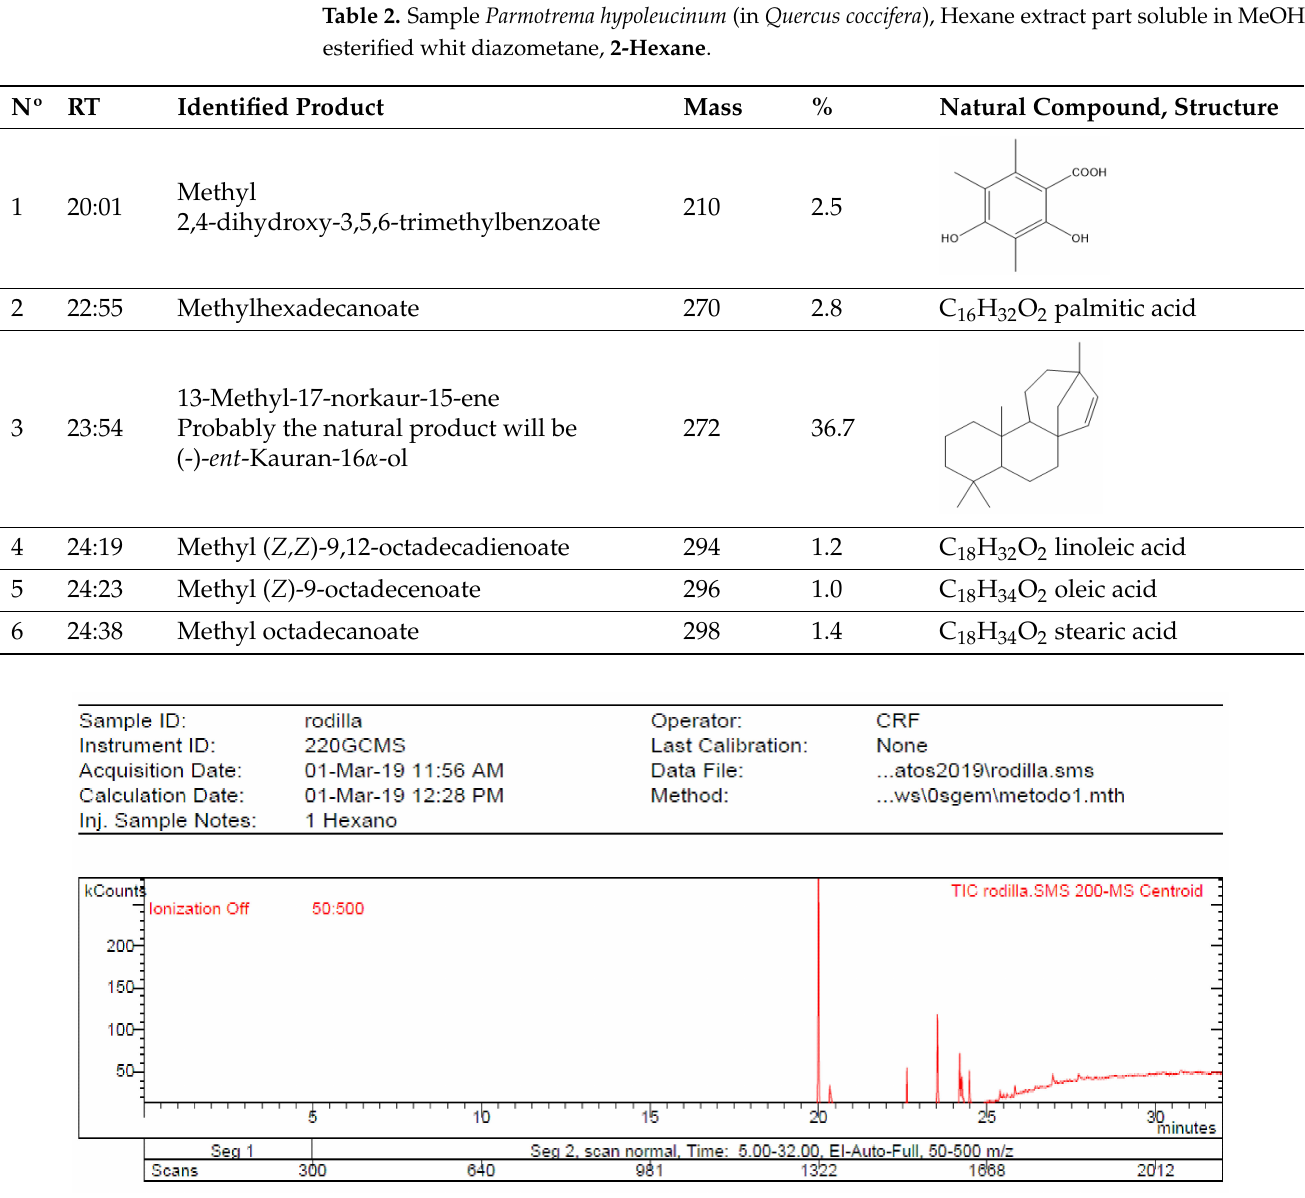
Figure 2. Chromatogram of Hexane extract part soluble in MeOH esterified with diazomethane, 1-Hexane .